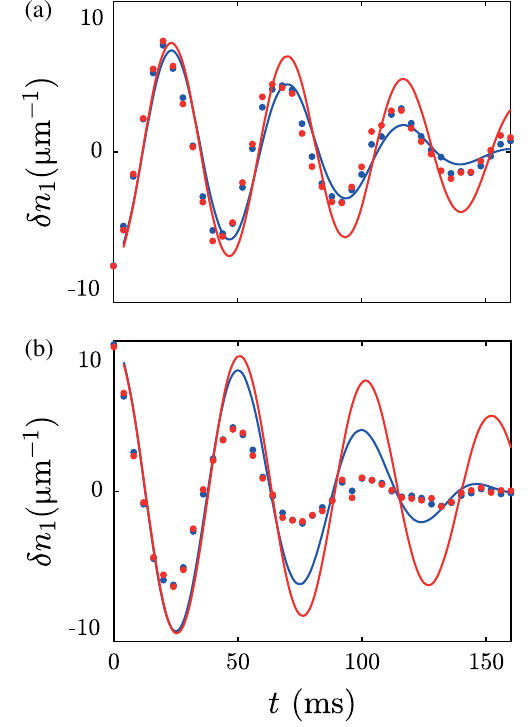
FIG. 12. Damping of the excited mode given two different atom number distributions with variance Δ N ¼ 20% (in blue) and Δ N ¼ 10% (in red). The dotted lines correspond to the damping extracted from experimental data, while the continuous lines show the TLL apparent relaxation expected assuming only dephasing among different realizations. The results shown refer to the two low-amplitude quenches illustrated in Fig. 2: The damping in (a) corresponds to the coldest quench, whose temperature is T ¼ 46 nK, and the damping in (b) corresponds to the hotter one, with T ¼ 120